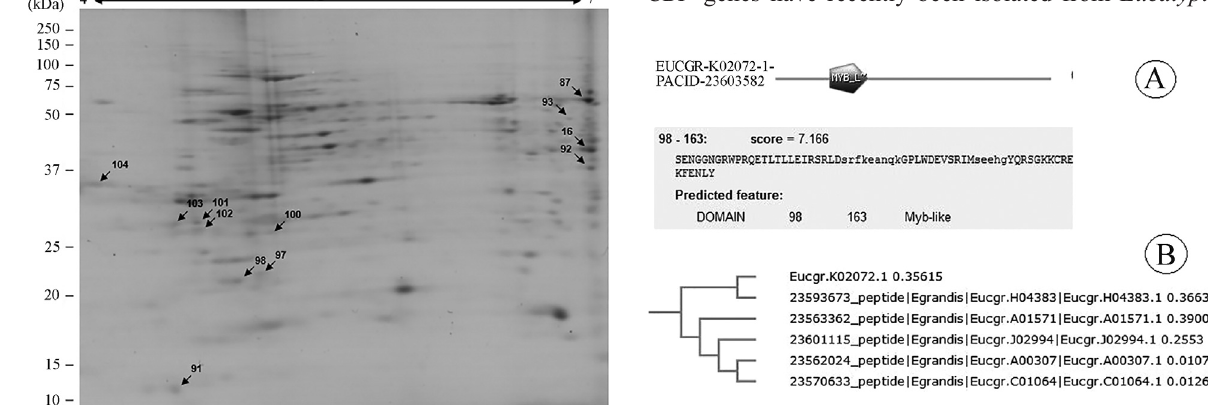
Figure 2 - Structure and molecular phylogeny analysis for the E. urograndis protein Eucgr.K02072.1 (A) ScanProsite output. Predicted myb-like domain profile extends from amino acid residue 98 through resi- due 163. (B) Neighbor-joining tree branch containing the E. urograndis protein Eucgr.K02072.1 and the closely-related E. grandis